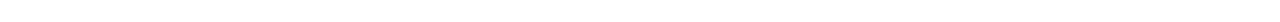
Fig. 2 Analysis of functional glomerular heterogeneity in OMP – / – glomeruli. a Raw two-photon fl uorescence of a glomerulus in an OMP – / – mouse. b , c Example time courses and average responses (dF/F) of the glomerulus in ( a ) to 4 different stimuli. Colored circles mark regions of interest and correspond to color of traces in ( b ). Green horizontal line marks stimulus delivery. d (Top) Projection of all pixels in ( a ) on two principal components (PC1 vs. PC2) reference coordinates. PCA was performed on the odor response spectra of each pixel. (Bottom) Average odor response spectra of